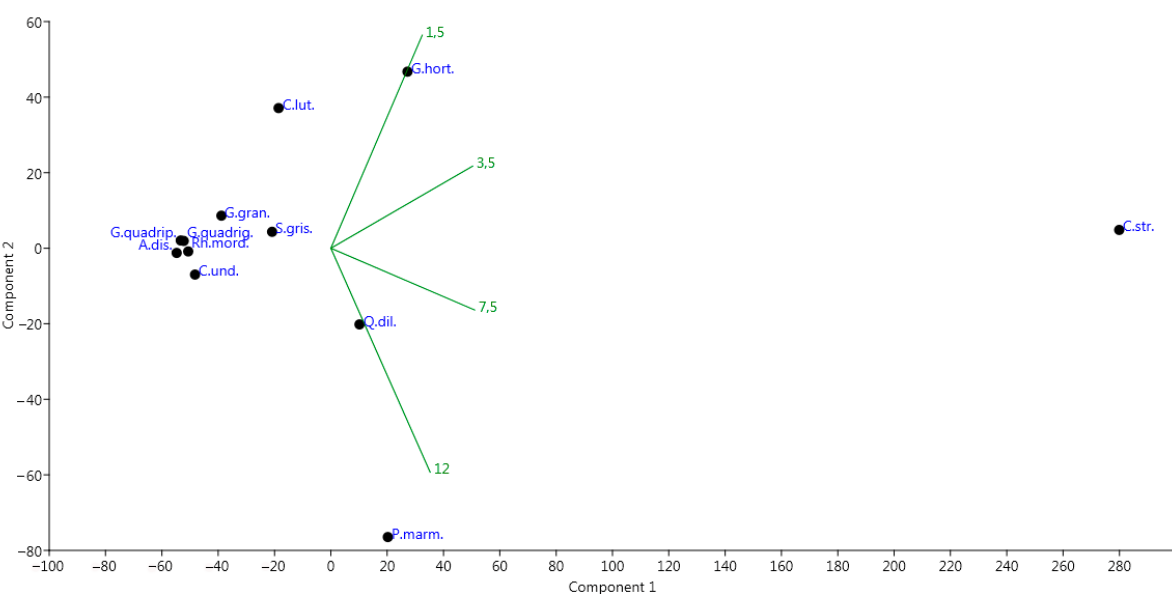
Figure 6. Principal component analysis (PCA) ordination diagram of the abundance species in the Republic of Mordovia (European Russia) based on the number of the collected species exemplars at various height of bait trap positions (1.5 m, 3.5 m, 7.5 m, 12.0 m). Designations: Q.dil.— Quedius dilatatus ; P.marm.— Protaetia marmorata ; C.str.— Cryptarcha strigata ; C.und.— Cryptarcha undata ; C.lut.— Cychramus luteus ; G.gran.— Glischrochilus grandis ; G.hort.— Glischrochilus hortensis ; G.quadrig.— Glischrochilus quadriguttatus ; G.quadrip.— Glischrochilus quadripunctatus ; S.gris.— Soronia grisea ; Rh.mord.— Rhagium mordax ; A.dis.— Anisandrus dispar . Groups of the height of beer trap positions were plotted onto PCA-ordination diagram as supplementary environmental variables.